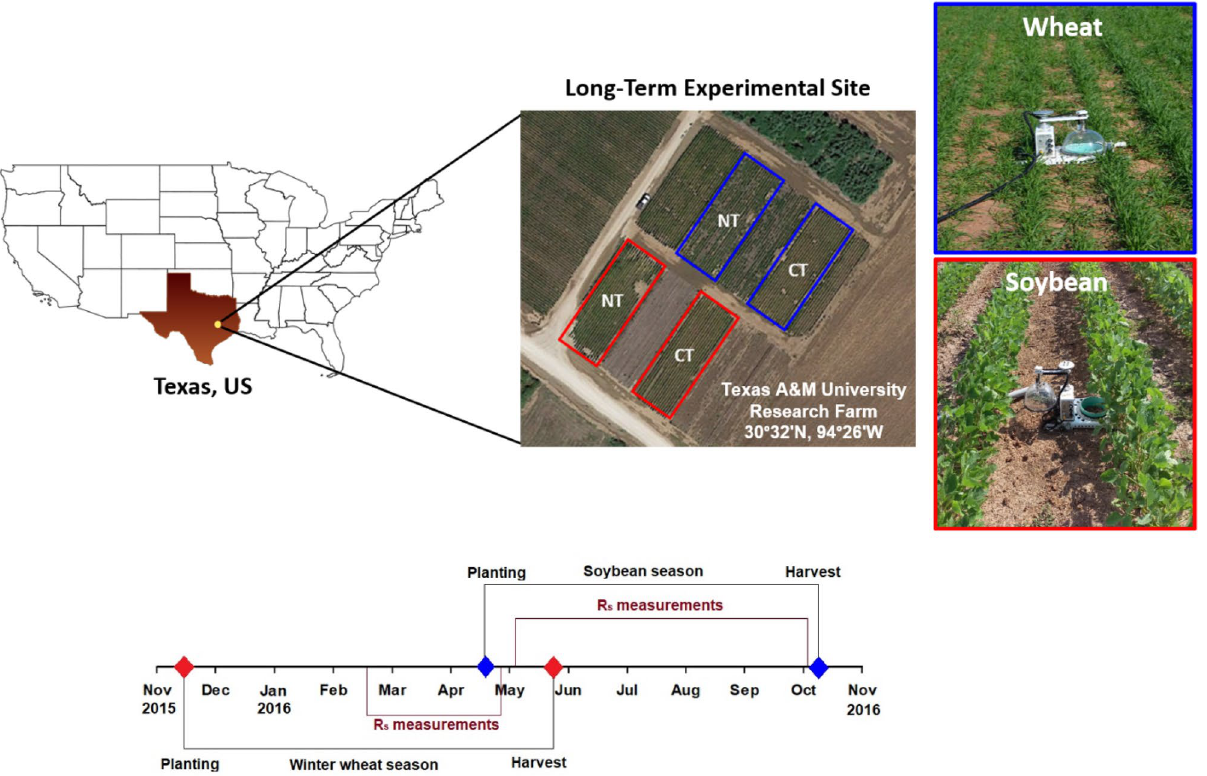
Figure 8. Location of the long-term agricultural experiment site at the Texas A&M University Research Farm. The conventional till (CT) and no-till (NT) plots are shown in blue (wheat) and red (soybean) boxes. A timeline is provided at the bottom that shows winter wheat and soybean growing seasons and periods of high-temporal soil respiration ( R s )